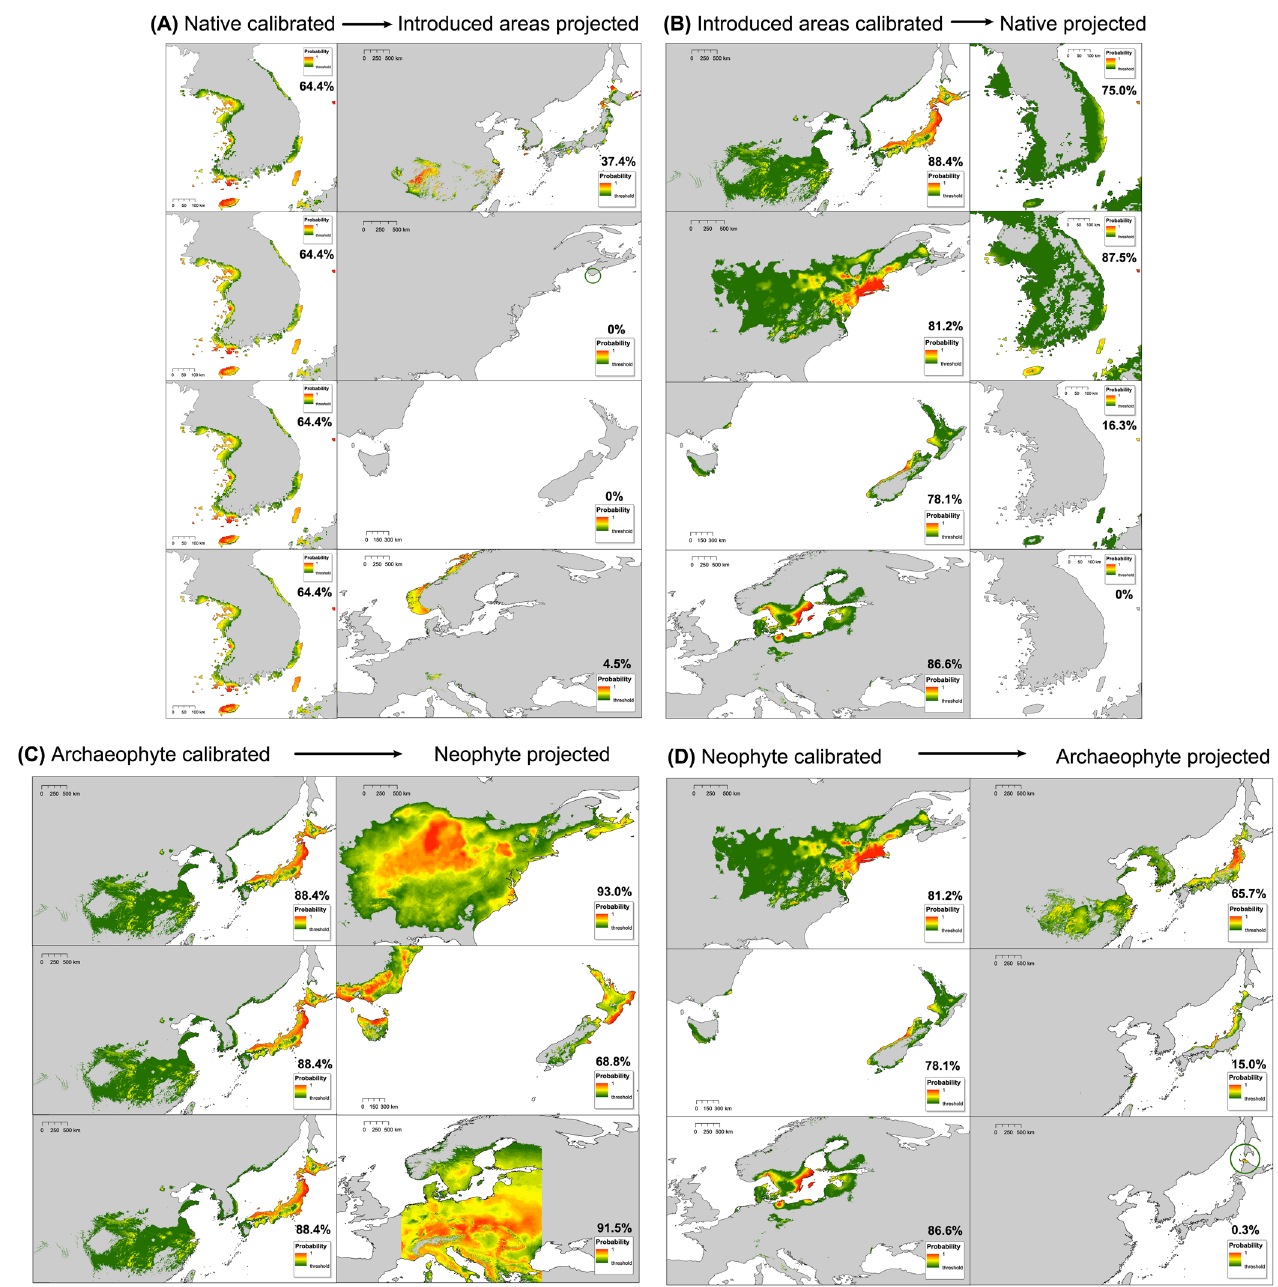
Figure 6. Reciprocal species distribution models (SMDs) calibrated ( A ) on the native range with its occurrence records and climatic data, and projected into climatic background conditions of introduced ranges (N → I), ( B ) on the introduced ranges and projected to the native area (I → N), ( C ) on the archaeophyte range (ASIA) and projected to neophyte ranges (USA-CA, AUS-NZ, and EUR) (Arc → Neo), and ( D ) on the neophyte ranges projected to the archaeophyte range (Neo → Arc). The percentage of correctly predicted occurrences by each model is also indicated. Color ramp represents habitat suitability measured in probability of occurrence, from green (showing low suitability) to red (high suitability). Geographic areas with probability values below selected threshold are colored in